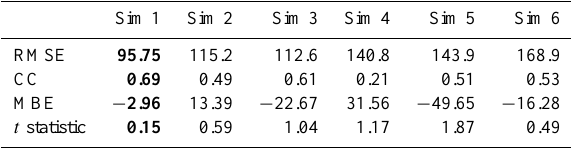
Table 3. Statistical evaluation of different simulations for LHF.